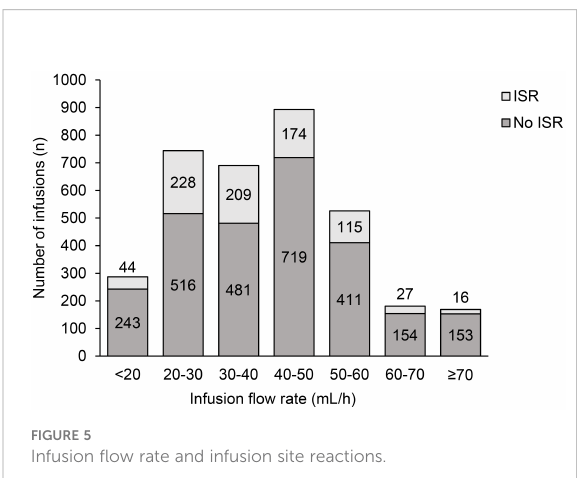
FIGURE 5 Infusion fl ow rate and infusion site